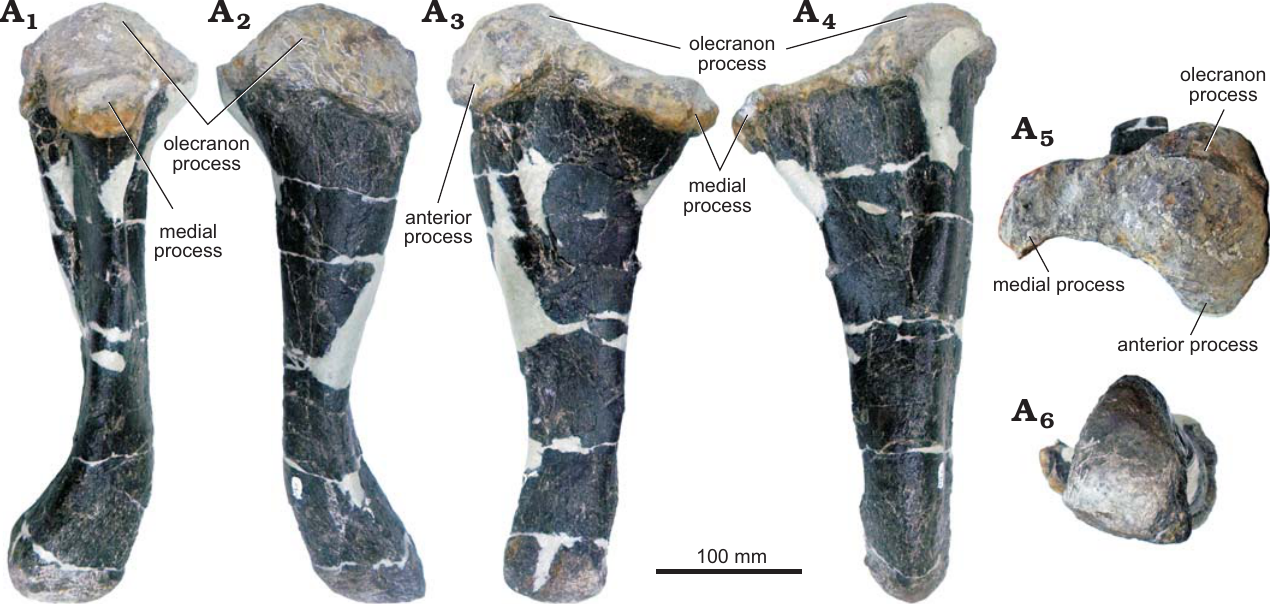
Fig. 16. Left ulna of stegosaur GPDM 178, near Giffen, Cascade County, Montana; in medial (A 1 ), posterior (A 2 ), lateral (A 3 ), dorsal (A 4 ), and ventral (A 5 )